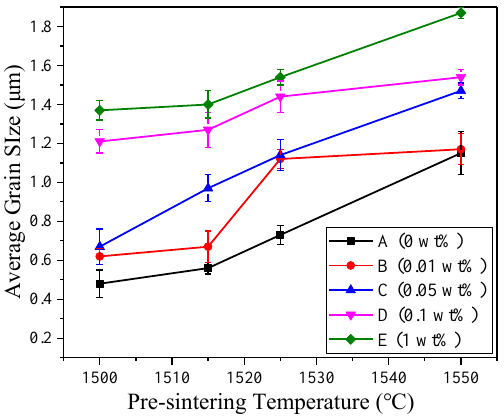
Figure 2. Pre-sintering behavior during pressureless sintering in air: average grain size versus pre- sintering